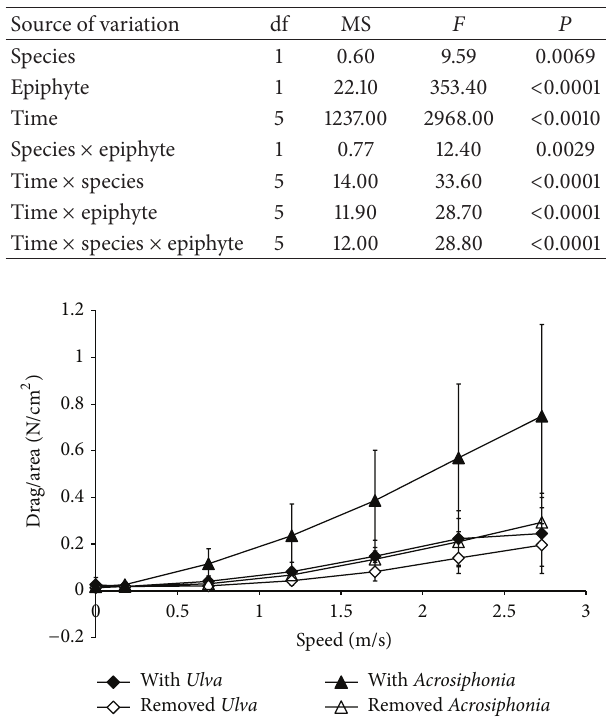
Table 4: RM-ANOVA analyses of limpet internal body temperature.